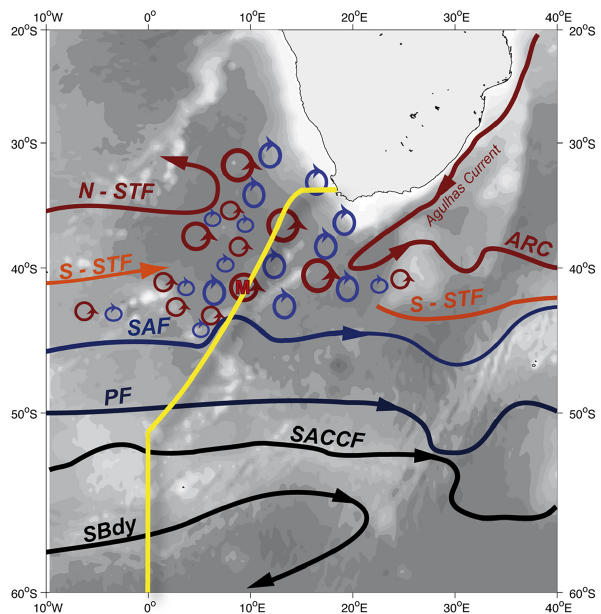
Fig. 1. Front locations (for the period 15 February–20 March 2008) based on satellite altimetry. ARC is the Agulhas Return Current; N- STF and S-STF are the Norhern and the Southern Subtropical Front (STF) respectively; SAF is the Subantarctic Front, PF is the Polar Front, SACCF is the Southern ACC front and SBy is the South- ern Boundary. Also shown are the ship track (yellow line) and the location of the “M” eddy (see